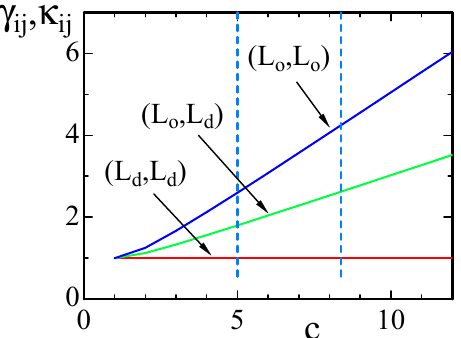
Figure 2. Three di ff erent values of γ ij and κ ij vs. c , where κ ij = γ ij =( c + c − 1 ) /2 on the ( L o , L o ) boundary, − 1 ) /4 on the ( L κ γ κ γ o , L d ) boundary and ij = ij =( 2 + c + c ij = ij = 1 on the ( L d , L d ) boundary. The dashed lines denote the values of c assumed in some of the